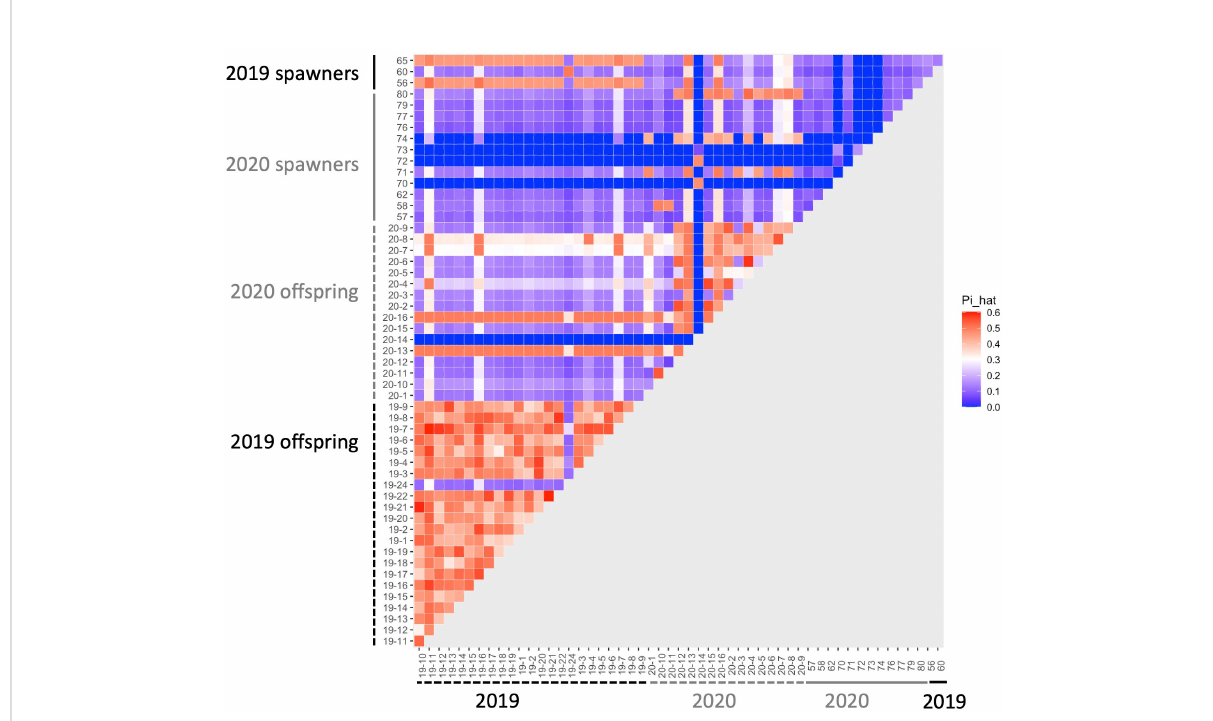
FIGURE 2 Heatmap of identity-by-descent (IBD) probabilities (pi_hat). Each square shows the probability of IBD for each pair of corals. Theoretical values of IBD indicate that values of ~1 indicates clones, ~0.5 indicates full siblings or parent-offspring, and ~0.25 indicates half